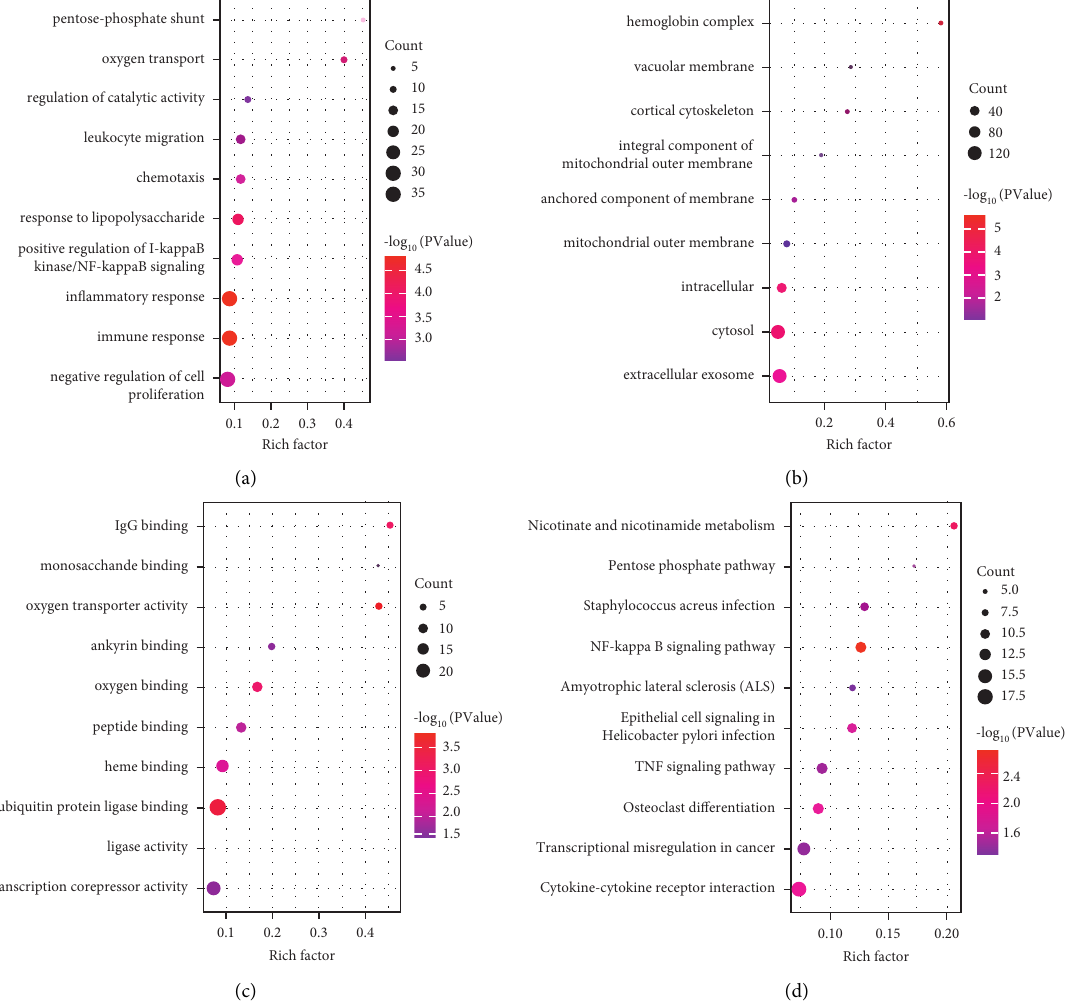
Figure 2: Thetop ten GO and KEGG enrichment terms for the differentially expressed mRNAs. (a) Biological process (BP), (b) cellular component (CC), (c) molecular function (MF), and (d) KEGG pathway. Note . The size of the circle represents gene counts. The color shows the P value, and the horizontal bar represents the corresponding P values. GO, Gene Ontology; KEGG, Kyoto Encyclopedia of Genes and